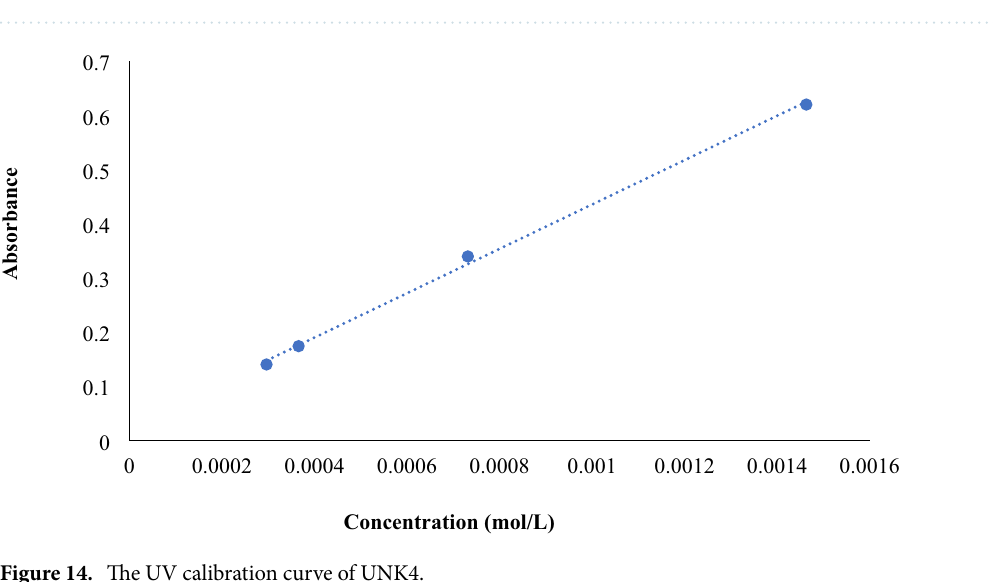
Figure 13. Plot of the experimental ΔG Binding (kcal/mol) values against the calculated ΔG Binding (kcal/mol) values for the known KRAS inhibitors.